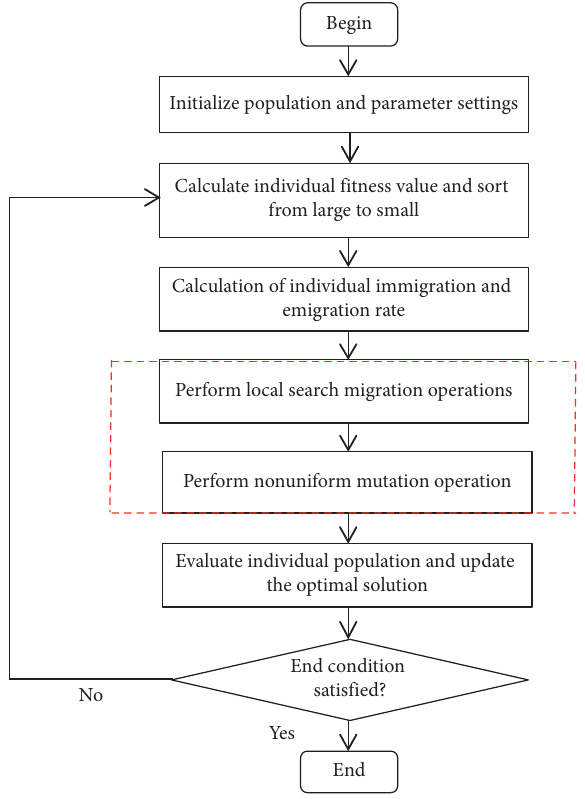
Figure 1: NBBO algorithm